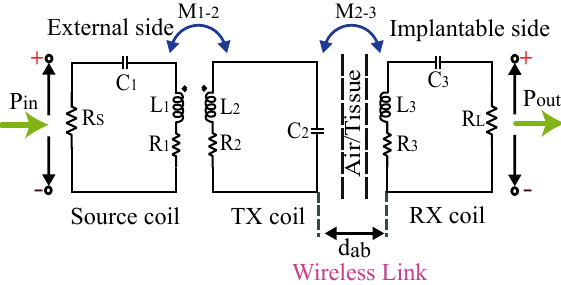
Figure 2. The equivalent circuit model of a 3-coil inductive link.